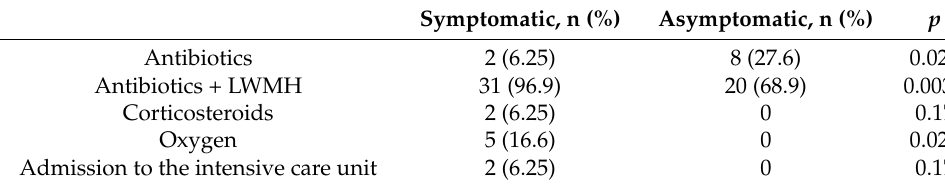
Table 3. Therapies in pregnant women with SARS-CoV-2 infection.